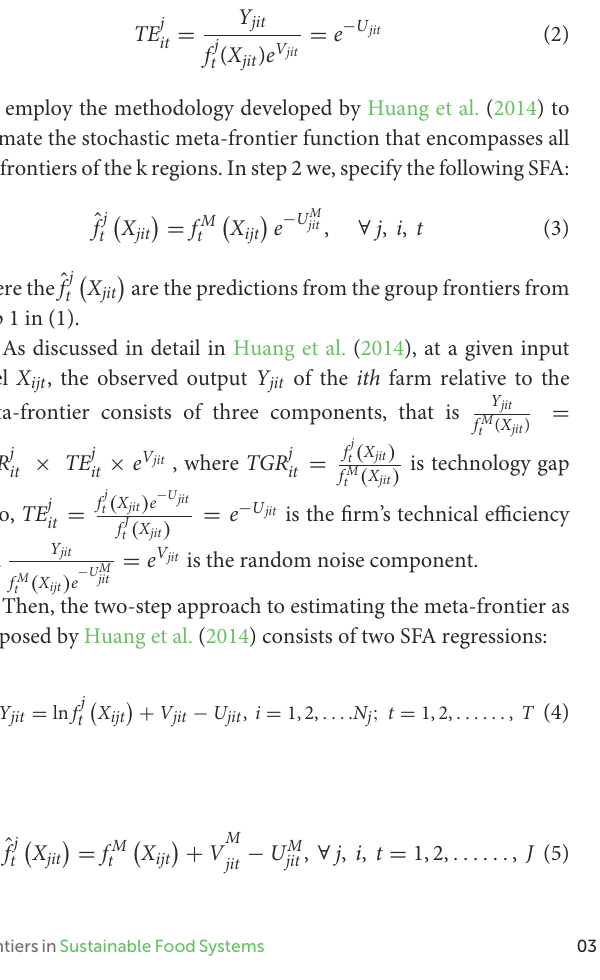
Where y jit denotes the output level for farm i in the j th region in the t th period, X jit is the input vector, V jit represents the error term and is assumed to be iid as V jit ∼ N (0, σ j 2 v ). U jit representing technical inefficiency and is distributed as U jit ∼ Z jit N + (cid:16) µ j , σ j 2 u Z jit (cid:1)(cid:17) , i.e., truncated from below at zero and (cid:0) (cid:1) (cid:0) with the mode at µ j Z jit , where Z jit s are some exogenous (cid:0) (cid:1)